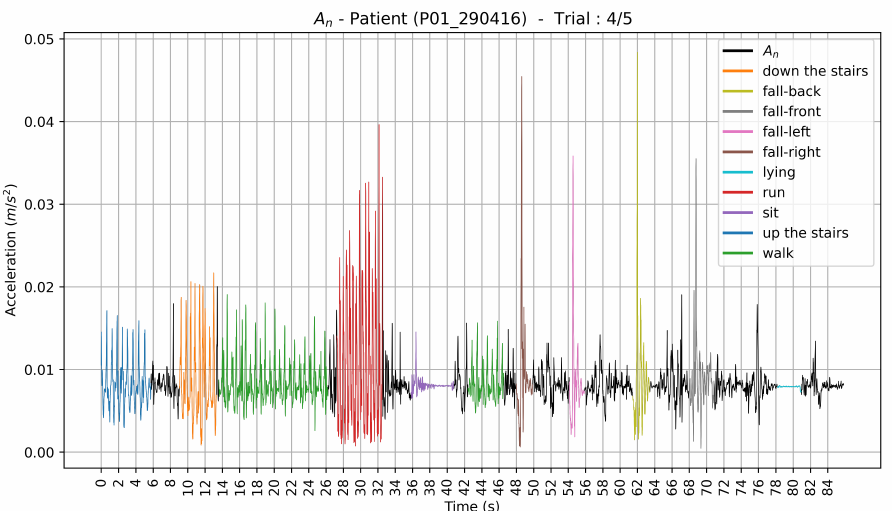
Figure 4. Plot of the raw normalized and labeled accelerometer data corresponding to one trial of a given participant (P01_290416). Each data cluster corresponding to an activity label has a different color on the plot.